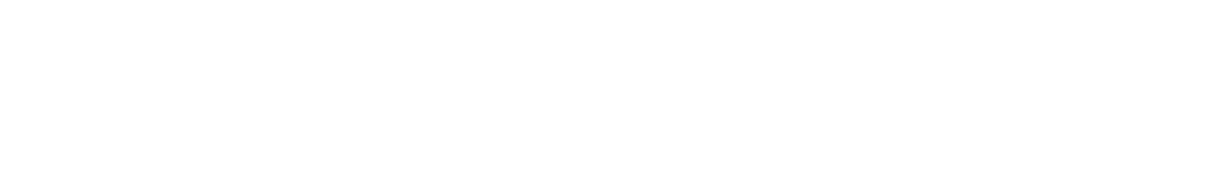
eGFR = estimated glomerular filtration rate (Chronic Kidney Disease Epidemiology Collaboration formula) Data are unadjusted means (standard error) in the upper part and age-, sex-, BMI- and linguistic region-adjusted means in the lower part. * p-values from t test, chi-squared test or Wald test as